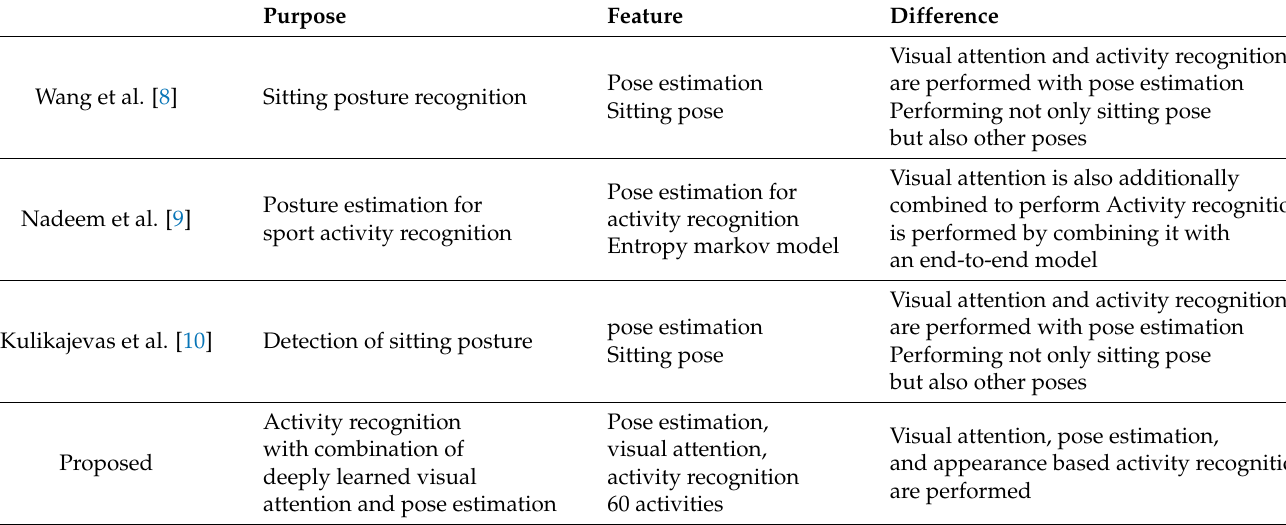
Table 1. Comparison with other